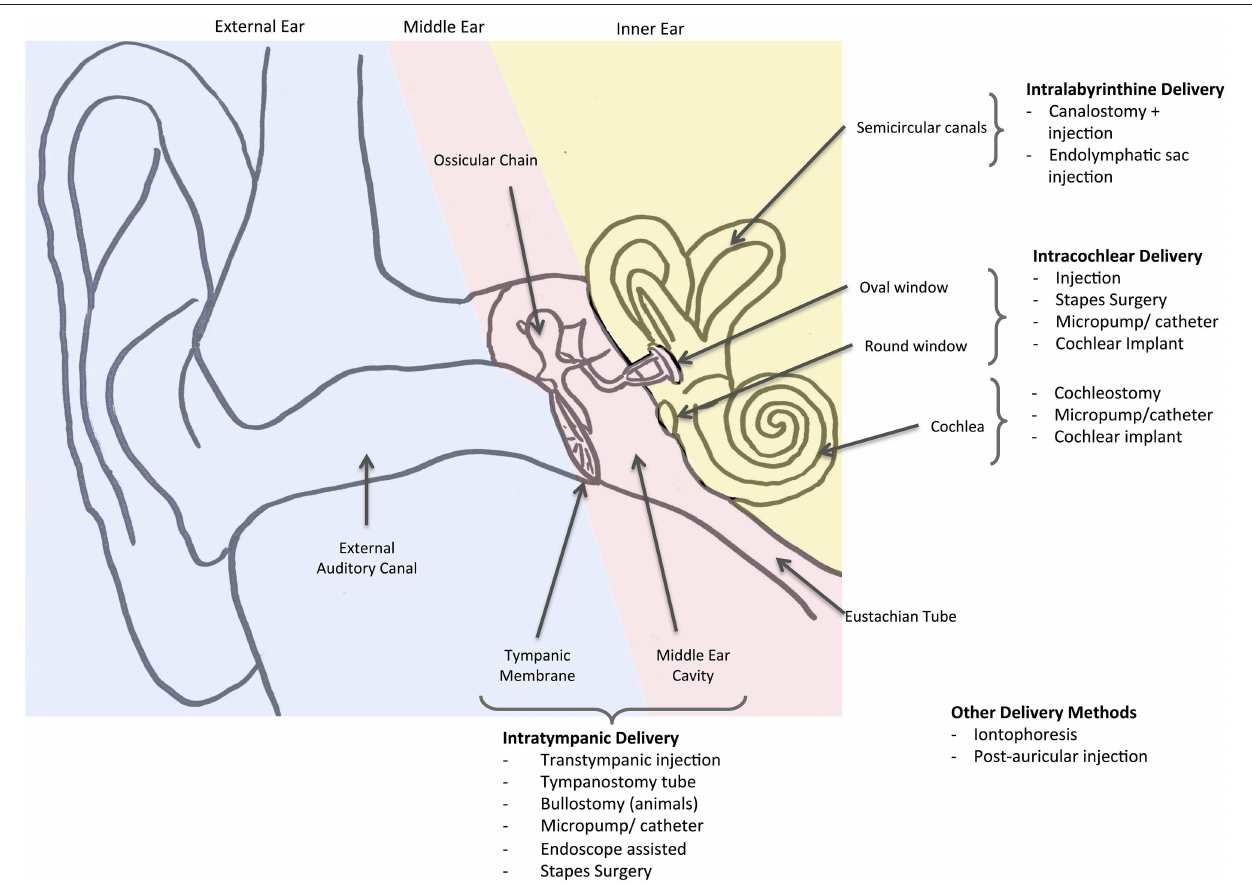
FIGURE 1 | Schematic figure summarizing the structure of the inner ear and delivery routes.